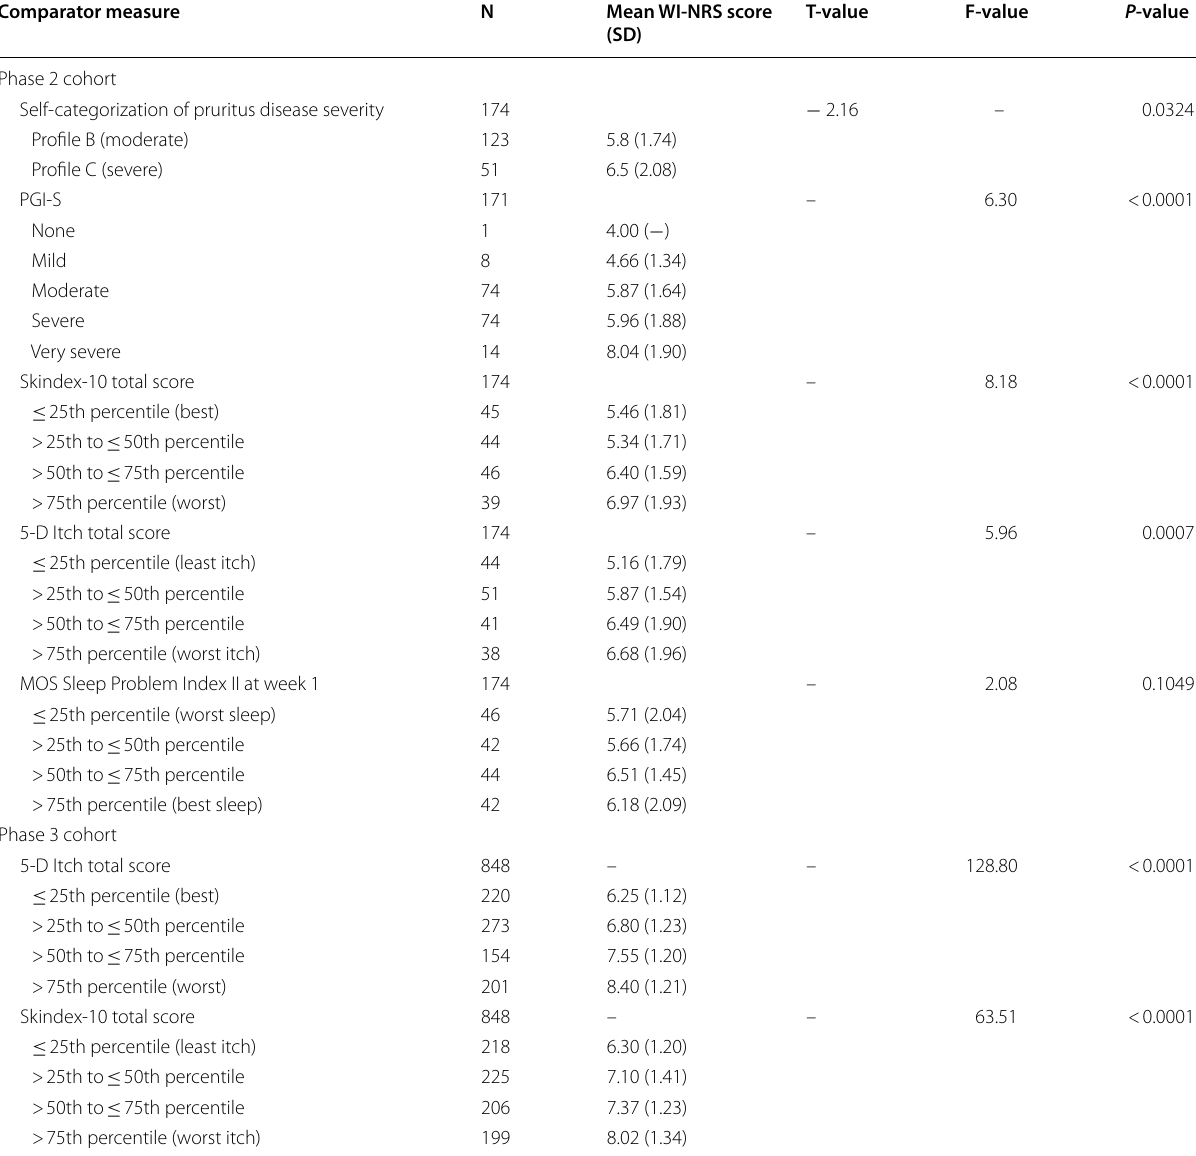
Table 4 Known-groups validity of WI-NRS vs. other measures at